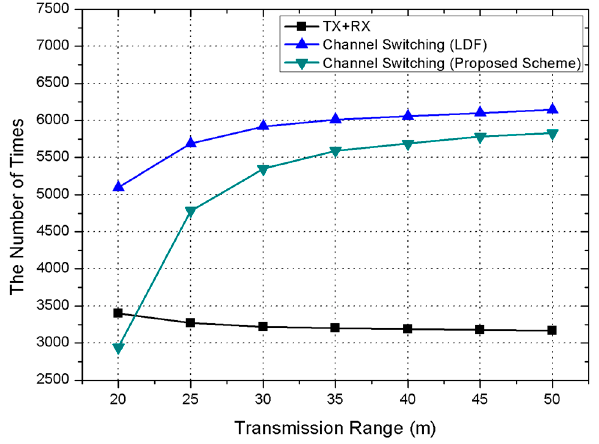
Figure 6. Simulation result on the number of channel switching nodes.